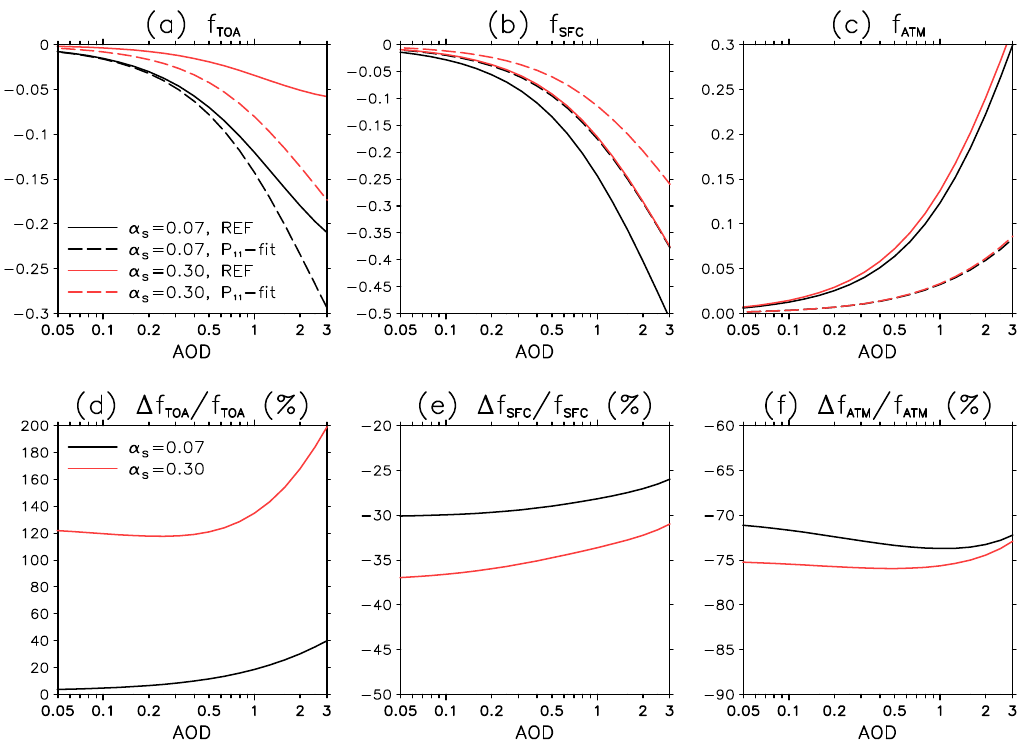
Figure 9. (a–c) Normalized aerosol radiative effects (Eqs. 12–14) for the REF (solid lines) and P 11 -fit cases (dashed lines) for surface albedos of α s = 0 . 07 (black) and α s = 0 . 30 (red). (d–f) Corresponding relative differences (in %) between the P 11 -fit and REF